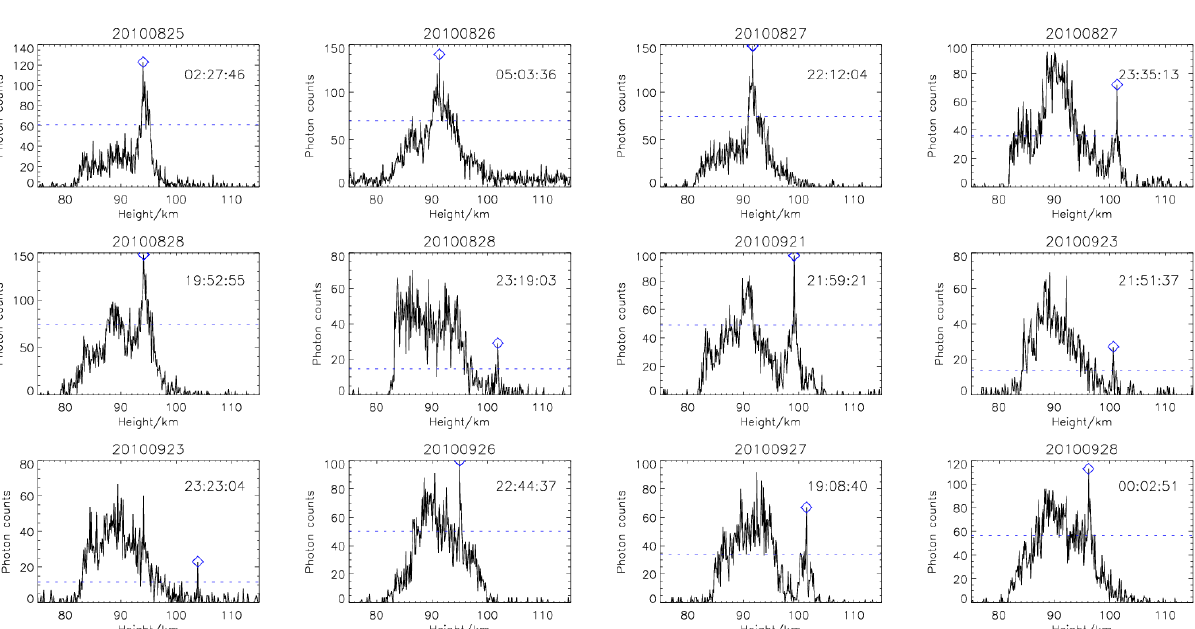
Fig. 7. The most typical 1.5s photon count profiles during each Na s layer observed to show the reliability of observations. The blue diamond represents where the Na s layer appeared, and the blue dashed line indicates the half maximum of the peak photon